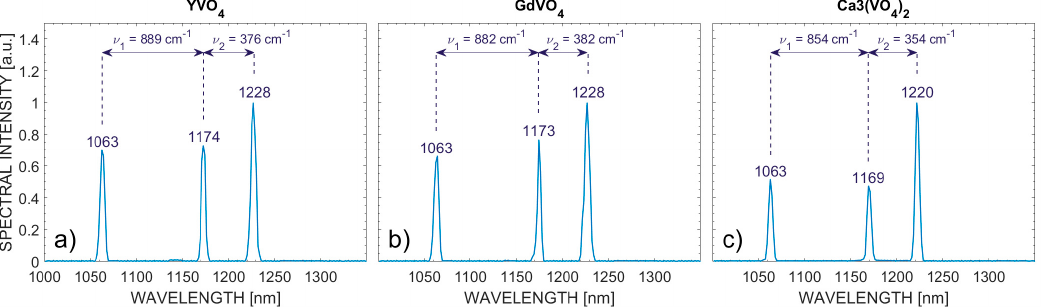
Figure 4. Laser output radiation spectra of the ( a ) YVO 4 , ( b ) GdVO 4 , and ( c ) Ca 3 (VO 4 ) 2 Raman lasers with OC2.